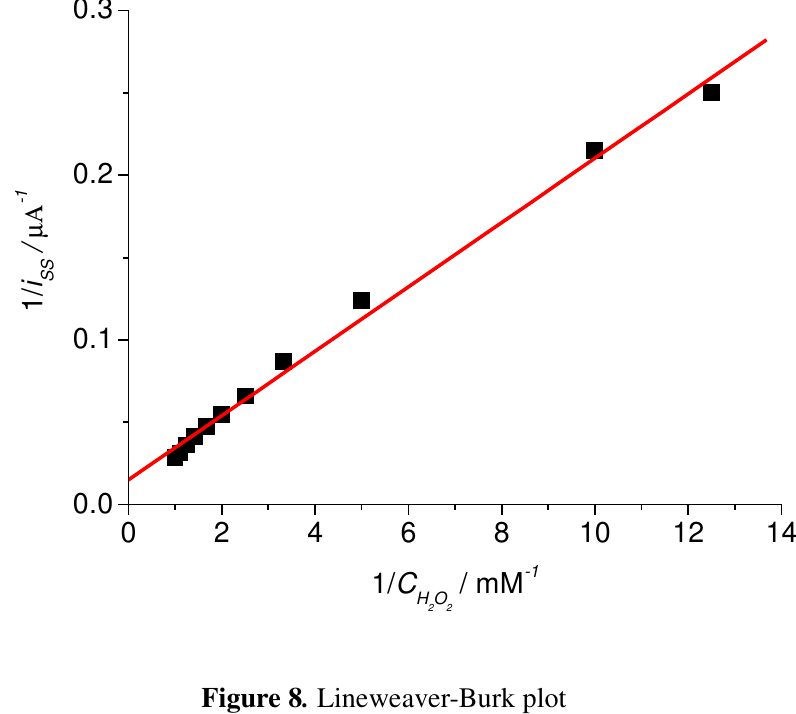
Figure 8 . Lineweaver-Burk